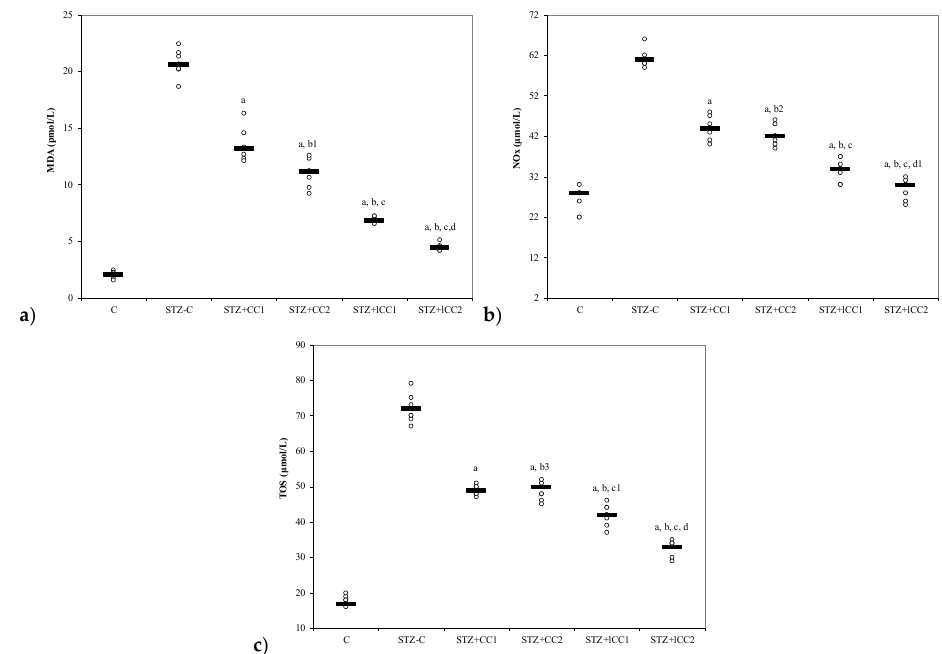
Figure 1. Variability of oxidative stress intensity by groups: ( a ) MDA (malondialdehyde) and ( b ) NOx (nitric oxide). C = control; STZ-C = streptozotocin control; STZ + CC1 = STZ and 1 mg/100 g bw CC as pre-treatment; STZ + CC2 = STZ and 2 mg/100 g bw CC as pre-treatment; STZ + lCC1 = STZ and pre-treatment with 1 mg/100 g bw lCC; STZ + lCC2 = STZ and pre-treatment with 2 mg/100 g